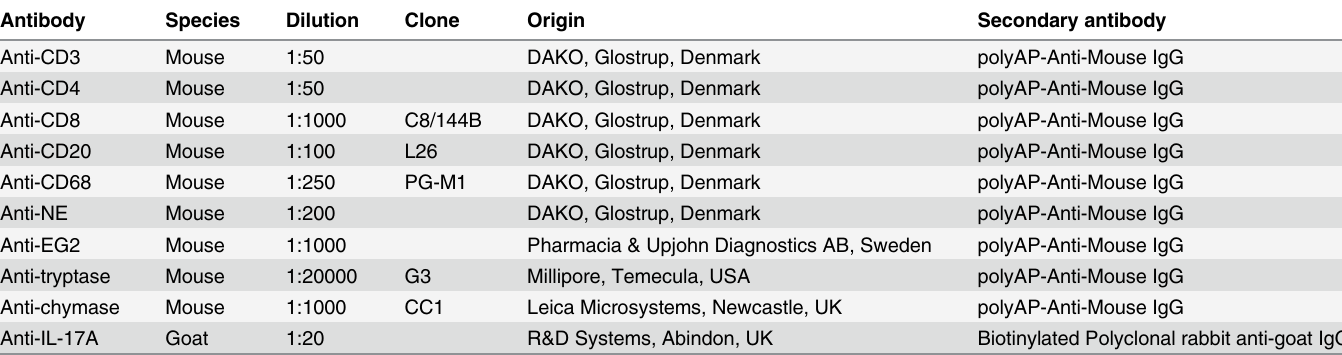
Table 1. Antibodies used for immunohistochemistry.